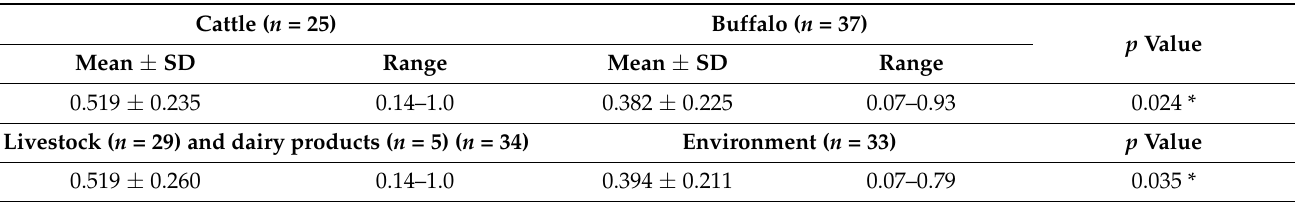
Table 5. Comparison of MAR index between different sample sources (livestock, dairy products and environment).